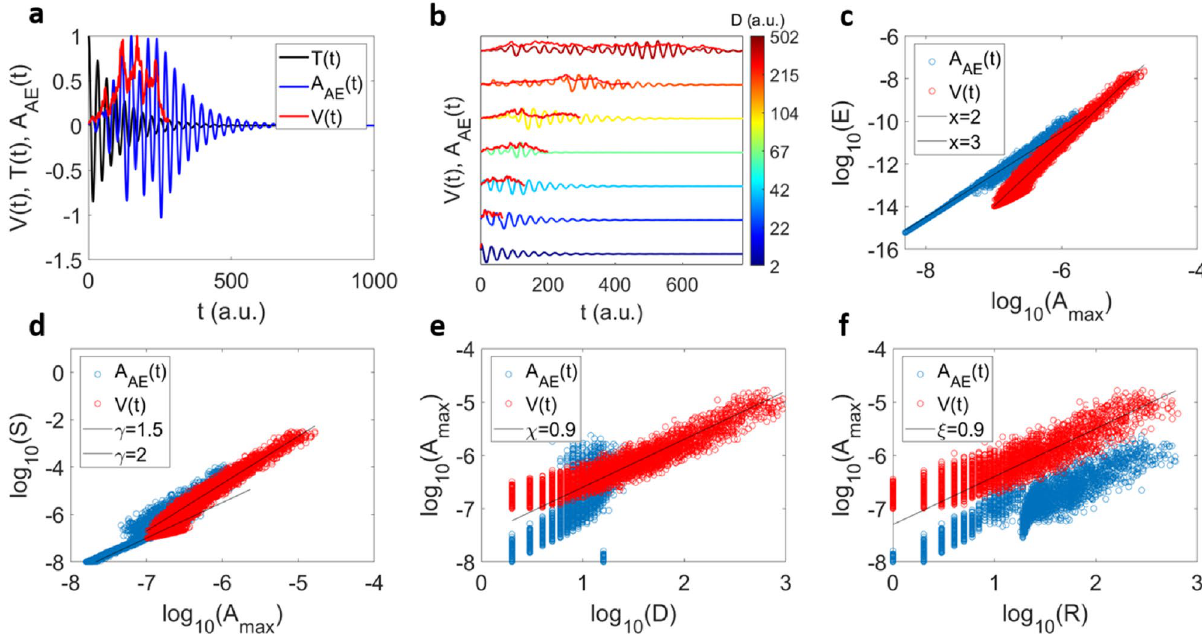
Figure 6. Scaling relations of the slip model before and after convolution. ( a ) Example of a convolution leading to A AE ( t ) (in blue) from an avalanche profile V ( t ) (in red) and a transfer function T ( t ) = cos ( wt ) e − qt (in black). ( b ) Examples of 6 convoluted avalanche profiles for different source functions V ( t ) with different durations, and the same transfer function. Both convoluted and original profiles are normalized with respect to their maxima. D χ ( e ) and A max R ξ ( f ) for the original V ( t ) S A γ max ( d ), A max A x ( c – f ) scaling relations E max ( c ), ∼ ∼ ∼ ∼ profiles (red points) and after the convolution A AE ( t ) (blue points). For e) and f) the exact exponent values in mean field theory are Χ =1 and ξ